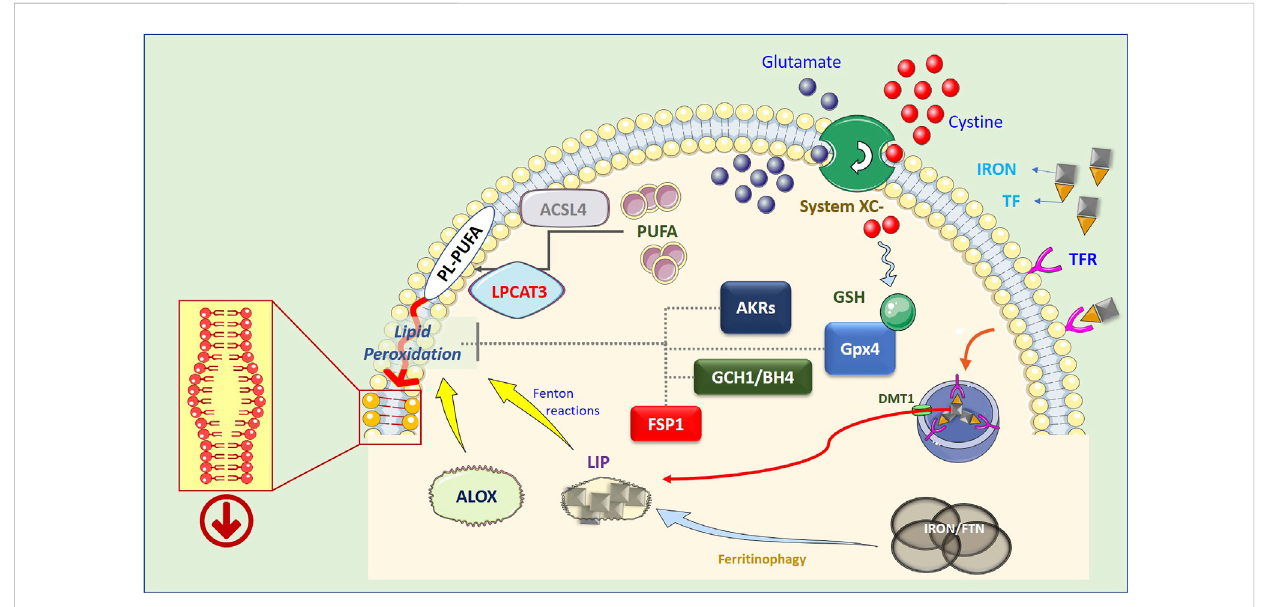
FIGURE 1 Schematicrepresentation oftheferroptotic process. Lipid peroxidation resultingin thegeneration ofLipid-ROS isconsidered thepoint ofno return in the execution of ferroptosis. However, the precise mechanism(s) by which these highly reactive molecules execute the cell death process is still not completely clear. The current hypothesis is that peroxidized PL-PUFAs destabilize the membrane thus compromising its barrier functions. PUFA are introducedintocellmembranes,asPL-PUFA,throughthecombinedactivityofACSL4andLPCAT3,whilelipidperoxidationiscatalyzedbyincreased available iron (LIP) through Fenton reactions, or by lipoxygenases (ALOX), which use iron as a cofactor. In turn, LIP can be generated by both ferritinophagy, which degrades intracellular and ferritin-based iron stores, or increased uptake of extracellular iron, through the iron/TF interaction with membraneTFRs,endosomalreleaseofiron,andDMT1-mediatedrelocationinthecytosol.Ontheotherhand,Lipid-ROScanbeactivelydegradedbythe GSH-dependent activity of GPX4, by increased expression/activity of AKRs, or can be reduced by the FSP1- or GCH1/BH4- dependent